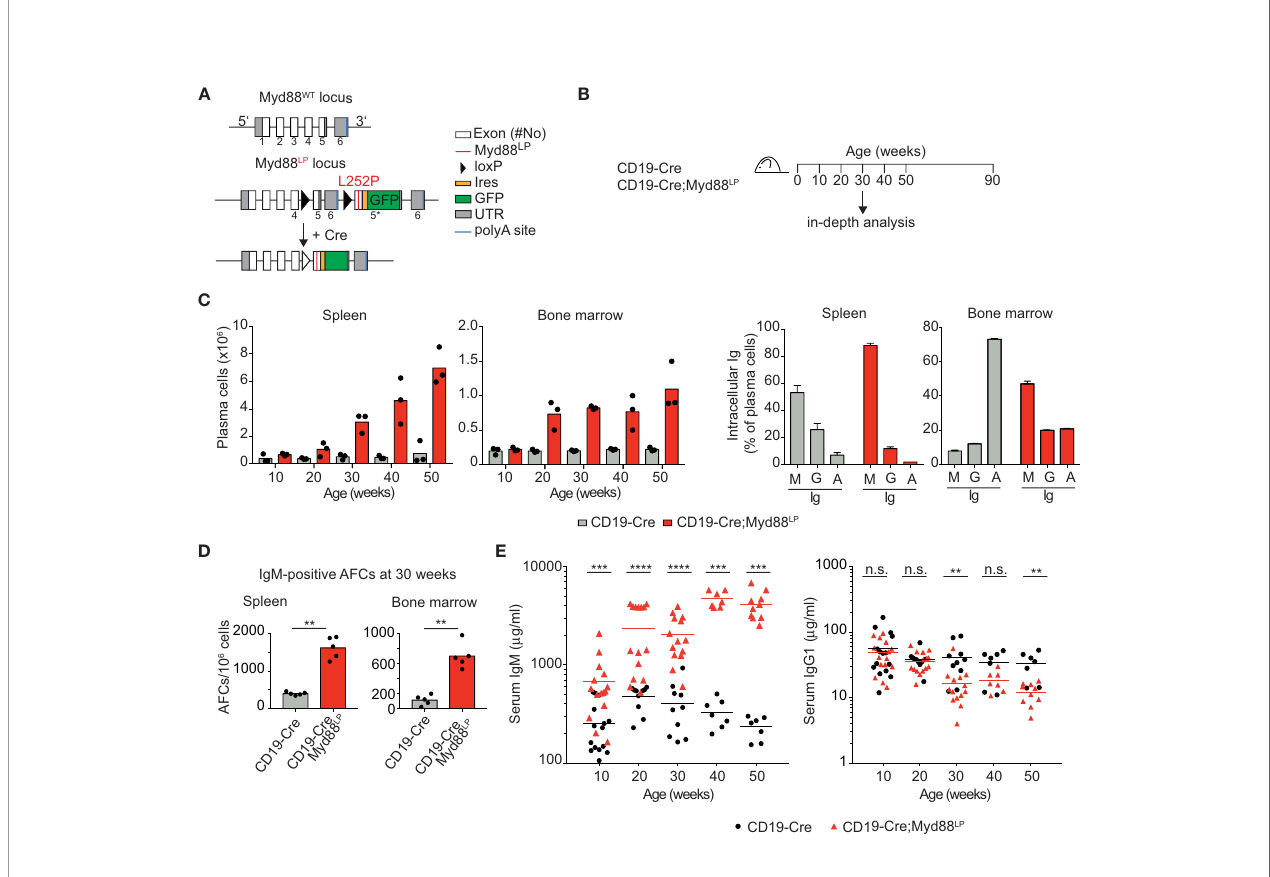
FIGURE 1 | B-cell-speci fi c Myd88 L252P expression causes increased IgM plasma cell and serum IgM levels. (A) Gene targeting strategy: Myd88 L252P -IRES-GFP was targeted into the endogenous Myd88 locus by homologous recombination. The wildtype exons 5 and 6 were fl anked by loxP sites that can be recombined by Cre recombinase, leading to expression of the mutant version. (B) Outline of the experiments shown in C – E and Table 1 . Mice of the indicated genotypes were observed for 90 weeks. (C) FACS analysis of spleen and bone marrow. Left: TACI + CD138 + plasma cell numbers increase over time. Right panels: Plasma cells expressed mostly IgM (30 weeks of age). (D) ELISPOT analysis in spleen and bone marrow at 30 weeks of age. IgM secreting antibody forming cells (AFCs) were elevated. (E) Serum immunoglobulin levels measured by ELISA. IgM titers increased over time while IgG1 titers decreased slightly. Results are representative of three independent experiments. (C – E) Each symbol represents one mouse. **p ≤ 0.01, ***p ≤ 0.001, ****p ≤ 0.0001, n.s. = not signi fi cant. (See also Supplementary Figures 1 – 4 ).